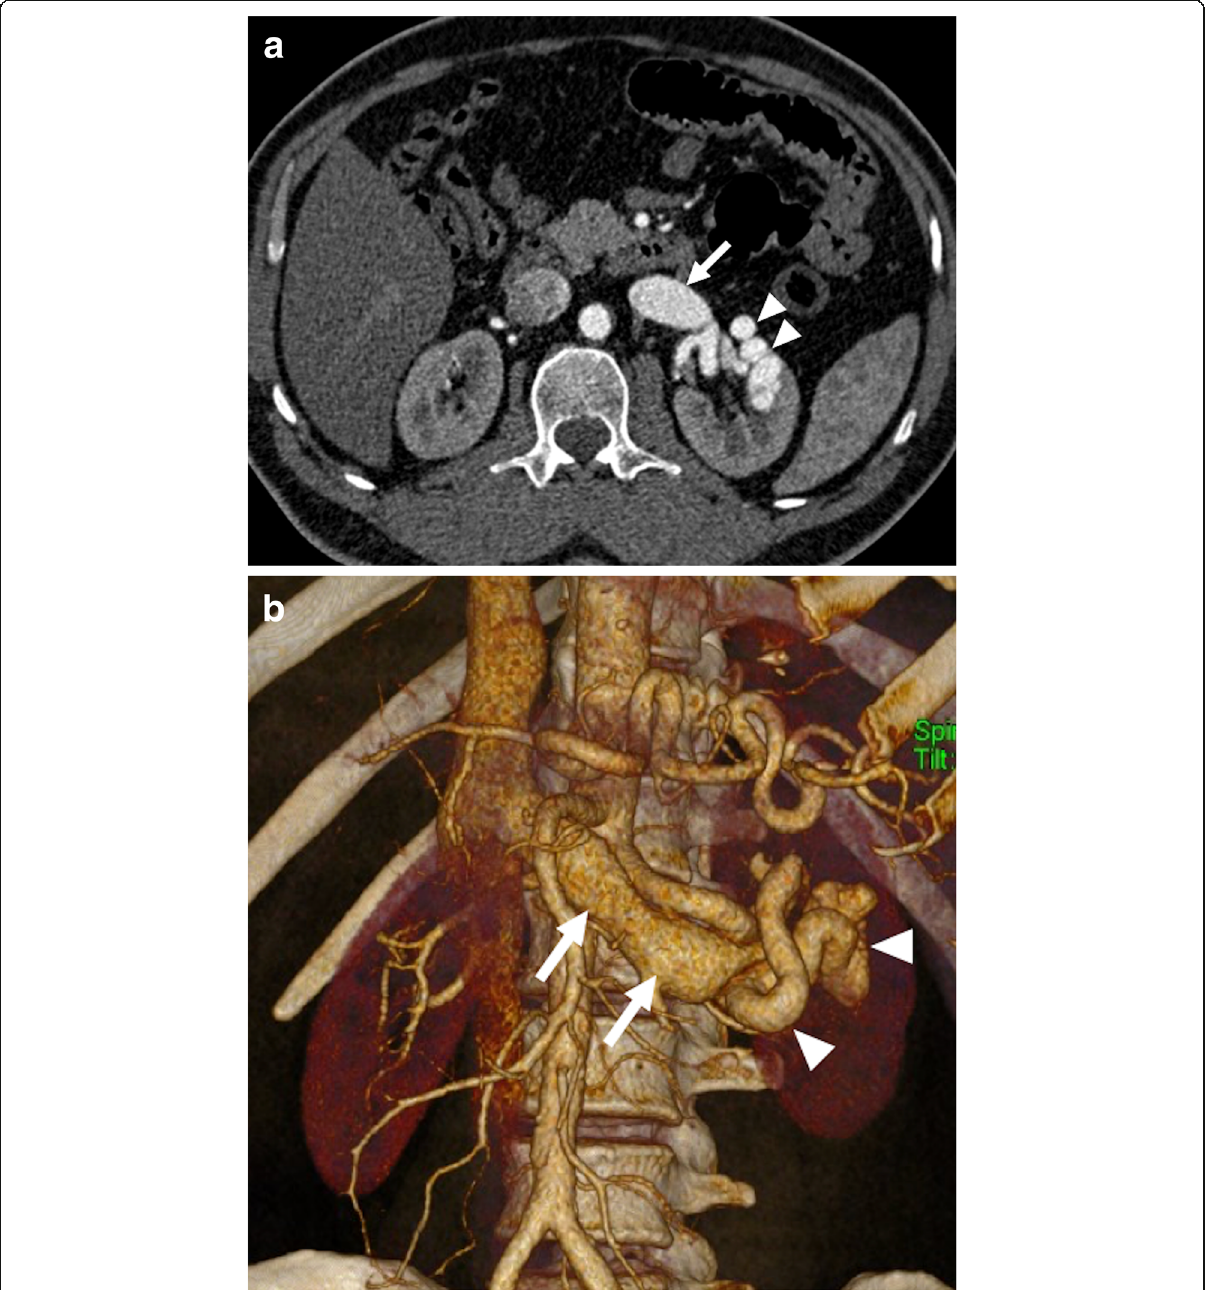
Fig. 16 Renal arteriovenous fistula. A 53-year-old male patient with a known history of nephrotic syndrome of unclear etiology presented to ED with recent-onset left flank pain and hematuria 2 months after percutaneous kidney biopsy. a Arterial phase axial plane post-contrast CT image showed early contrast filling of the dilated left renal vein (arrow). Also, note is made of associating ectatic venous structures within the renal hilum (arrowheads). b Coronal volume rendered image shows dilated left renal vein (arrows) with tortuous fistula tract having fusiform dilations (arrowheads) within the renal hilum. The patient was subsequently treated with surgical ligation and